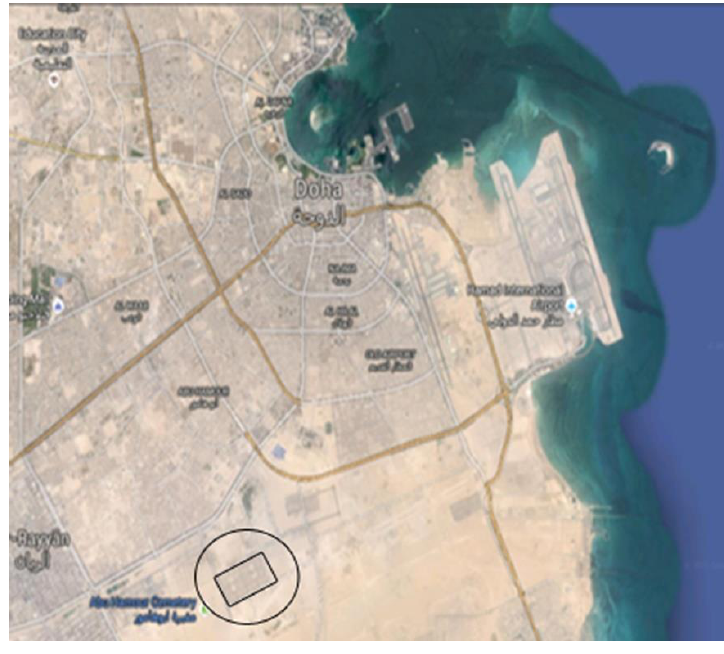
Figure 2. Barwa city location ( Google Maps, 2016)